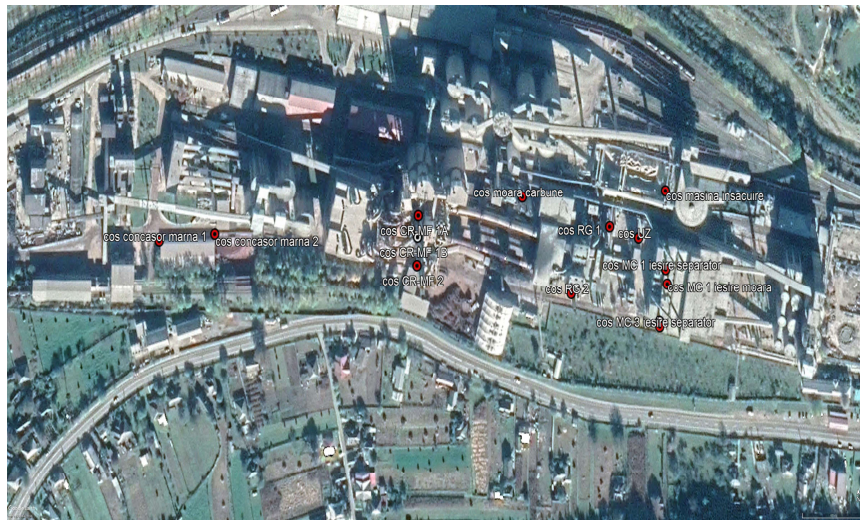
Figure 14. Representation of emission sources (stacks) in Google Earth Pro .